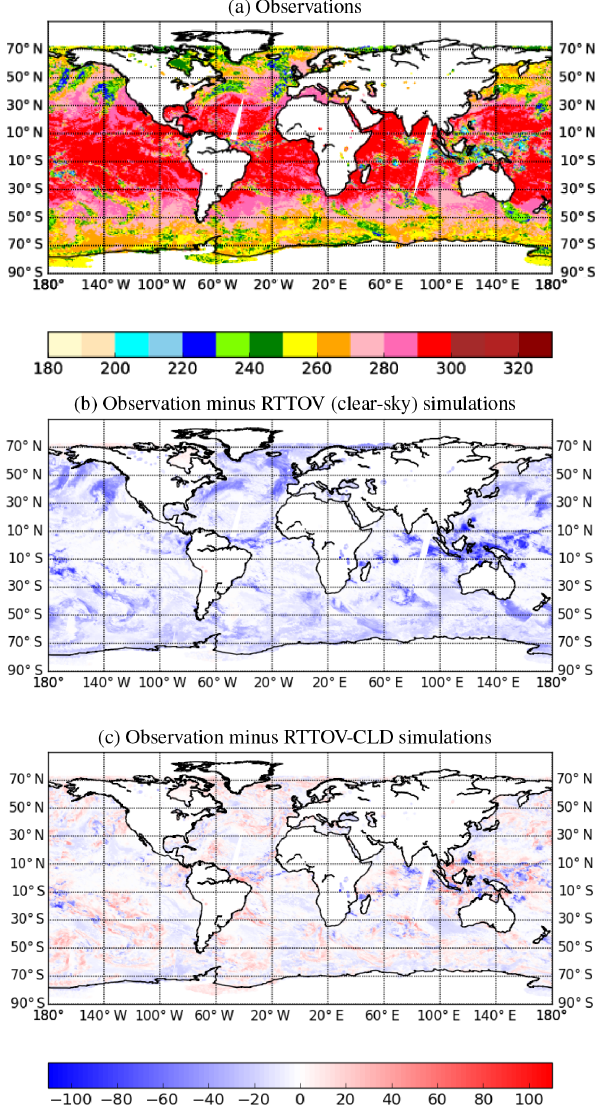
Figure 1. IASI brightness temperature (K) observations (a) from Metop A and B satellites and differences (K) between observations and simulations using RTTOV (b) and RTTOV-CLD (c) for the sur- face channel (1271, 962.5cm − 1 ) for 30 January 2017 daytime over sea from ARPEGE 6h forecast